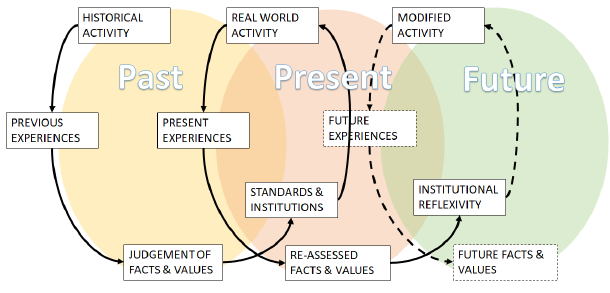
Fig. 1 . Institutional reflexivity as an outcome of new experiences and new judgements (based on Vickers 1965 appreciative system; see also Checkland and Casar